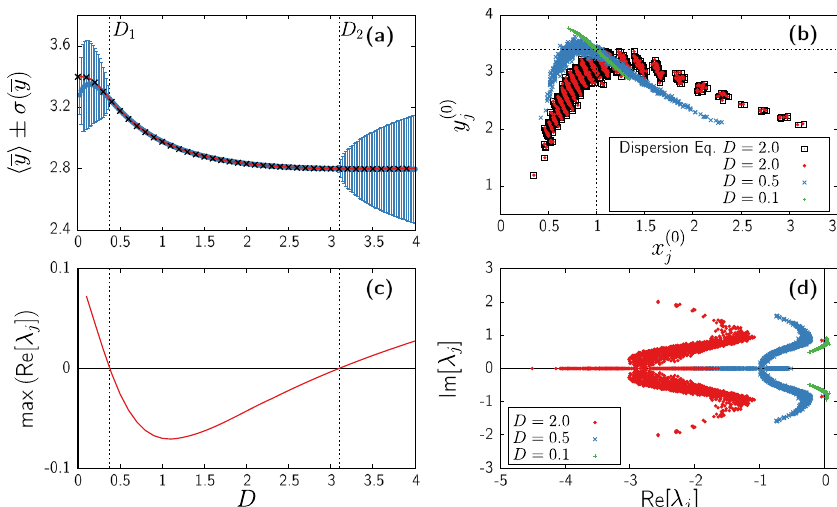
Fig. 3 Results of simulations and numerical analysis for the Brusselator model in an Erdös-Rényi (ER) network. System parameters for the reactive terms are a = 0.5 and b = 1.7. Network topology corresponding to a ER with N = 1000 nodes and average degree k h i ¼ 20. a Blue circles indicate the time- averaged mean- fi eld corresponding to the y variable of each node, h y i , obtained from numerical simulations for different values of diffusion D . Error bars indicate the temporal standard deviation of the mean- fi eld, σ ð y Þ (de fi nitions in the text). Red continuous line shows the mean- fi eld corresponding to the heterogeneous fi xed point obtained solving numerically the system of equations (4). Black crosses correspond to the mean- fi eld obtained by integrating the peturvative equation (5). Vertical black dashed lines indicate the bifurcation points derived from the stability analysis. b Coordinates of the heterogeneous fi xed point of the system ð x ð 0 Þ j ; y ð 0 Þ j Þ , j = 1, … , N , in the phase space. Green plusses, blue crosses, and red points correspond to numerical solutions of system (4) for different diffusion values D . Black squares correspond to the solution obtained by integrating Eq. (5) up to D = 2. Each symbol corresponds to a different network node j = 1, … , N . The crossing of the two black dashed lines indicate the equilibria of the uncoupled system, ( x (0) , y (0) ) = (1, b / a ). c Largest eigenvalue ’ s real part for different values of D . Vertical black dashed lines indicate the bifurcation points where the largest eigenvalue crosses de x axis. d Eigenvalue spectra in the complex plane for different values of D (same symbols as in b